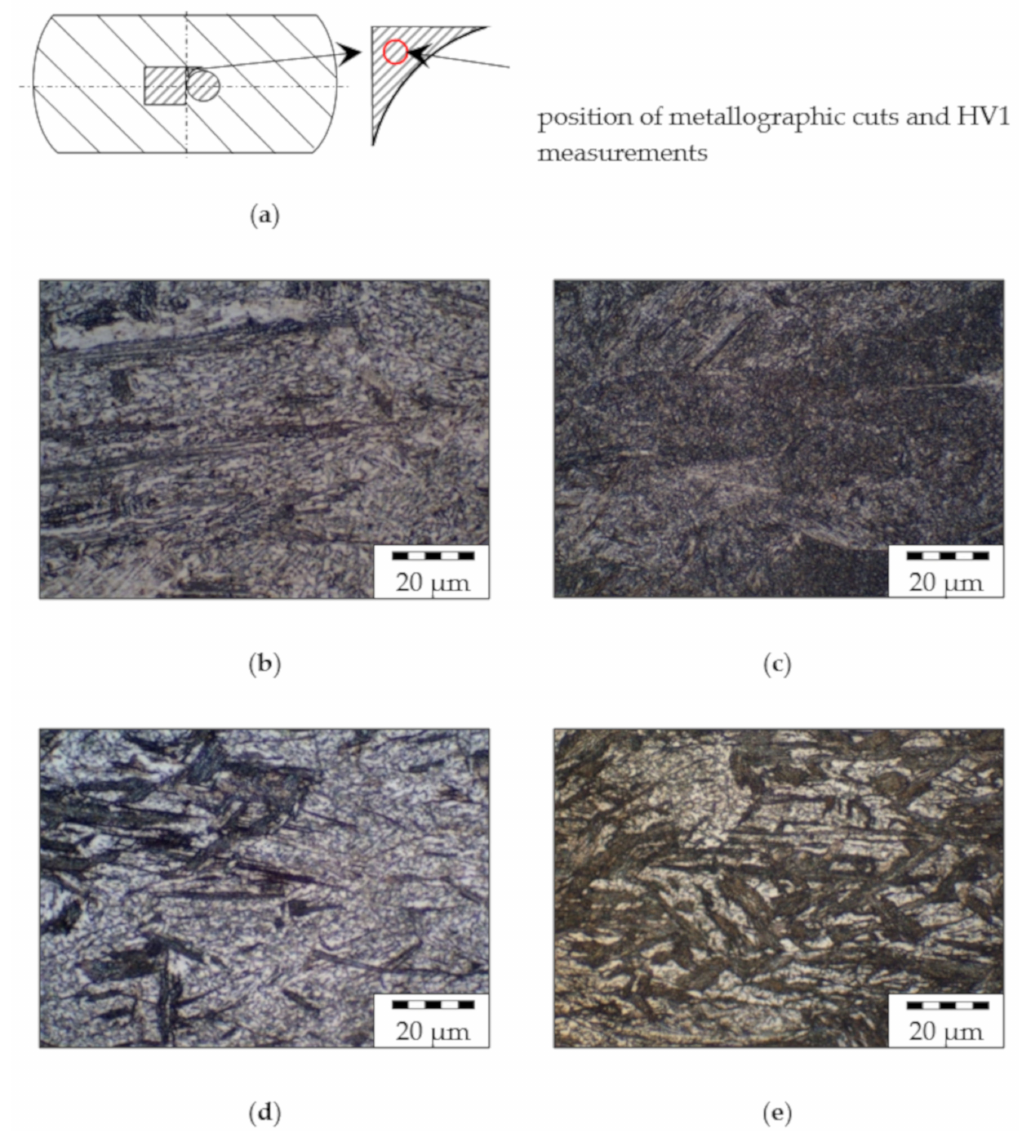
Figure 5. ( a ) Position of metallographic cuts and HV1 measurements, micrographs from TMT routes with high cooling rate and low secondary forming temperature (hl): ( b ) 0.3 + 0.3; ( c ) 0.6 + 0.3; ( d ) 0.3 + 0.6; ( e ) 0.3 + 0.9. Etched with nitric acid